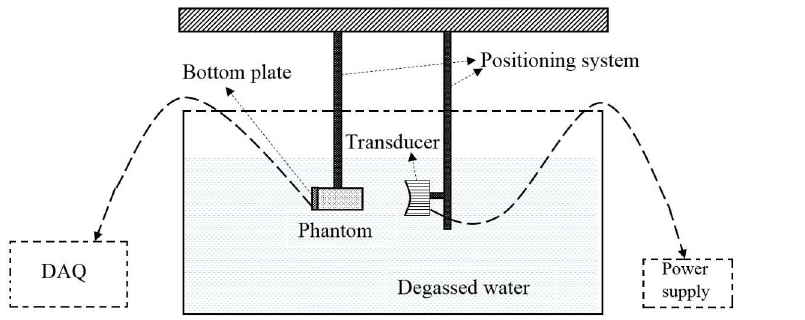
Fig 2. Experimental setup showing the transducer, phantom and the